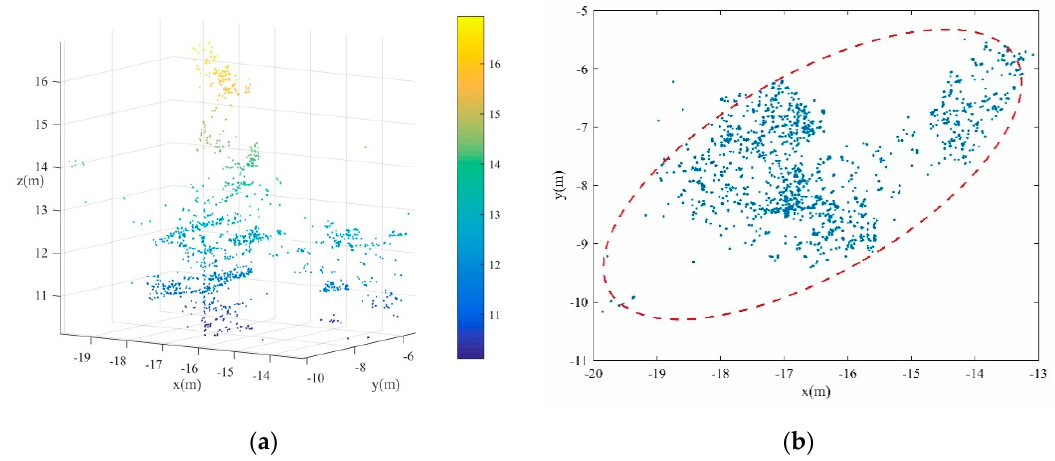
Figure 3. Undersegmented canopy points. ( a ) Canopy points of two adjacent trees are divided together; ( b ) the horizontal projection of the under-segmented canopy points tend to be